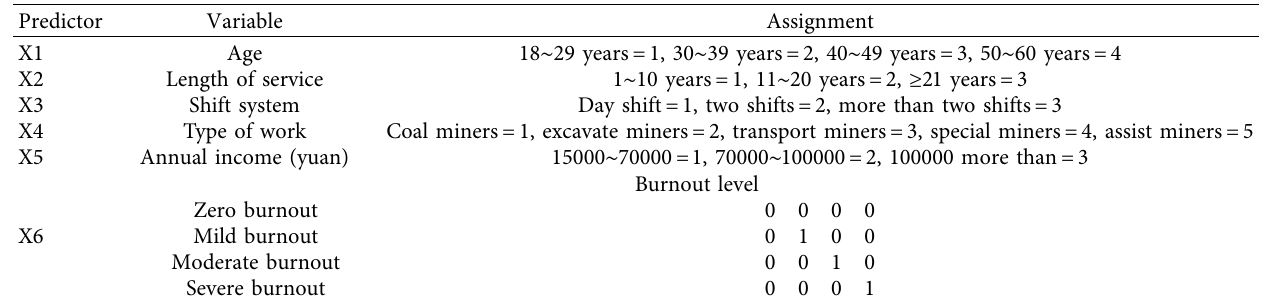
Table 5: Individual factor assignment table.